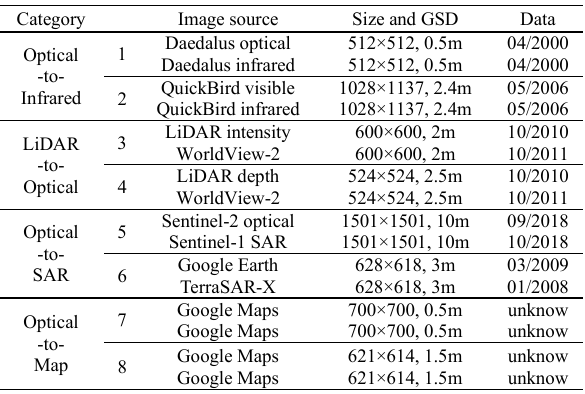
Table 1. Detailed information of all test